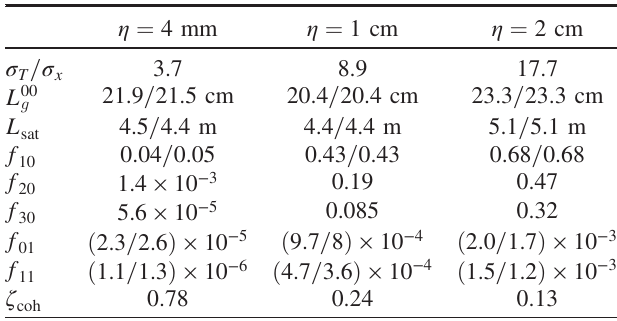
TABLE II. Saturation and transverse coherence parameters (single/first entry refers to data from the exact model while second entry contains variational